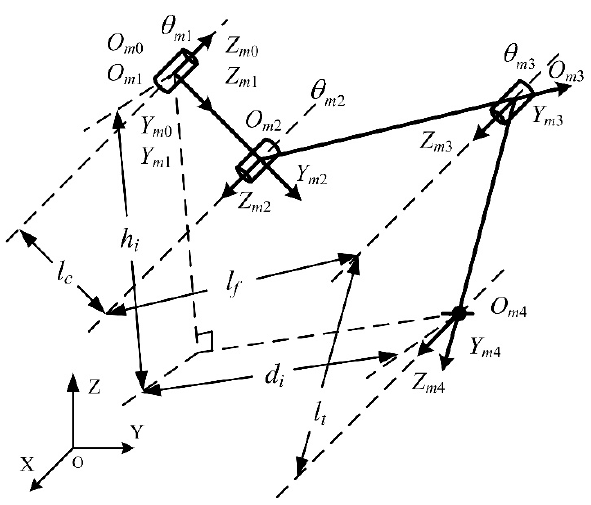
Figure 3. Joint coordinates of legs.